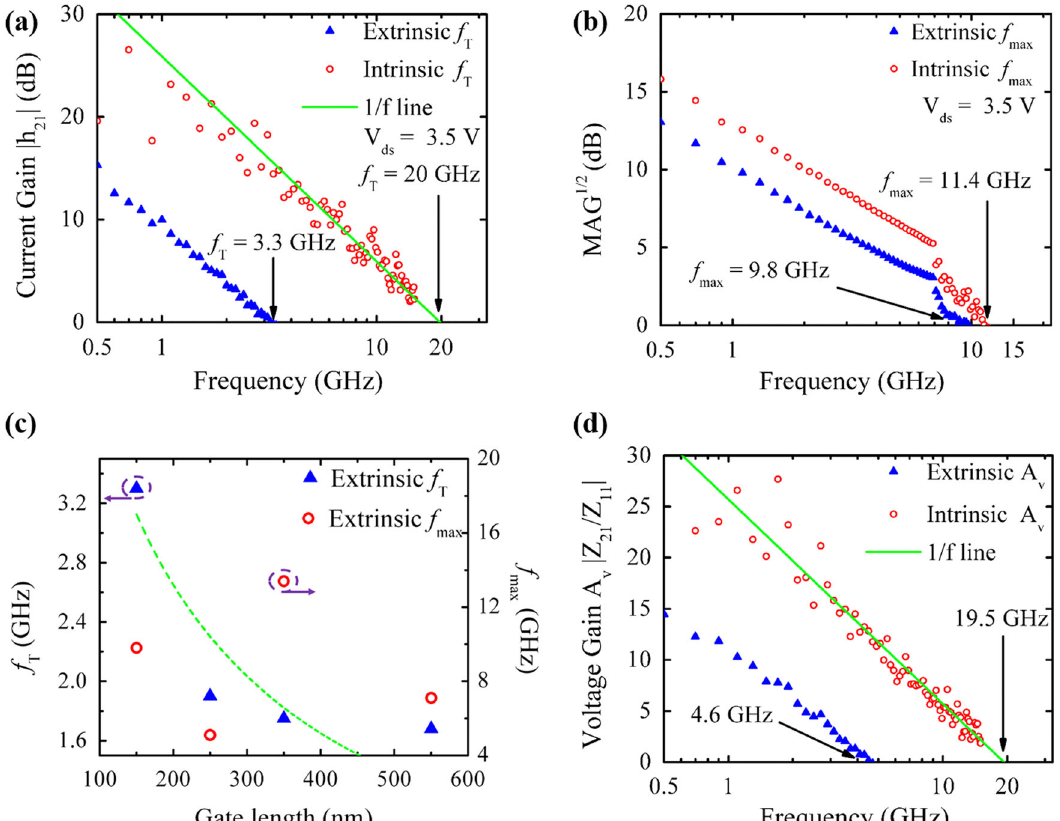
Fig. 3 RF characterization a Short circuit current gain, | h 21 | , vs. frequency showing an extrinsic f T of 3.3 GHz and an intrinsic f T of 20 GHz. The device shows good linearity with the expected − 20 dB/dec slope. b Maximum available power gain, MAG 1/2 , vs . frequency showing an extrinsic f max of 9.8 GHz and an intrinsic f max of 11.4 GHz. We attribute the high f max to current saturation-mediated low output conductance, g ds . c Extrinsic f T and f max as a function of gate lengths from 150 – 550 nm. The dashed line is a fi t of the f T − L g data to a 1/L line. d Voltage gain,